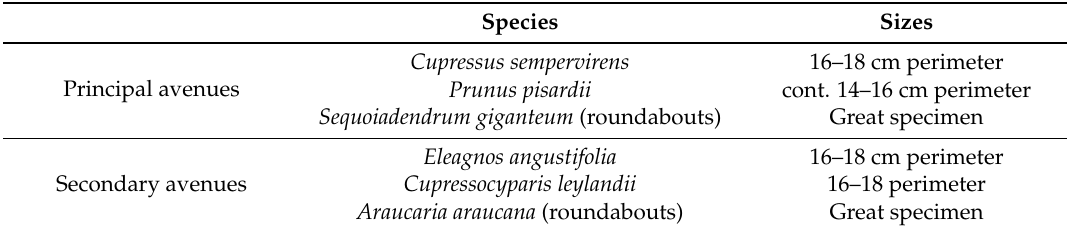
Table 11. Species for the planting of agroforestry avenues.